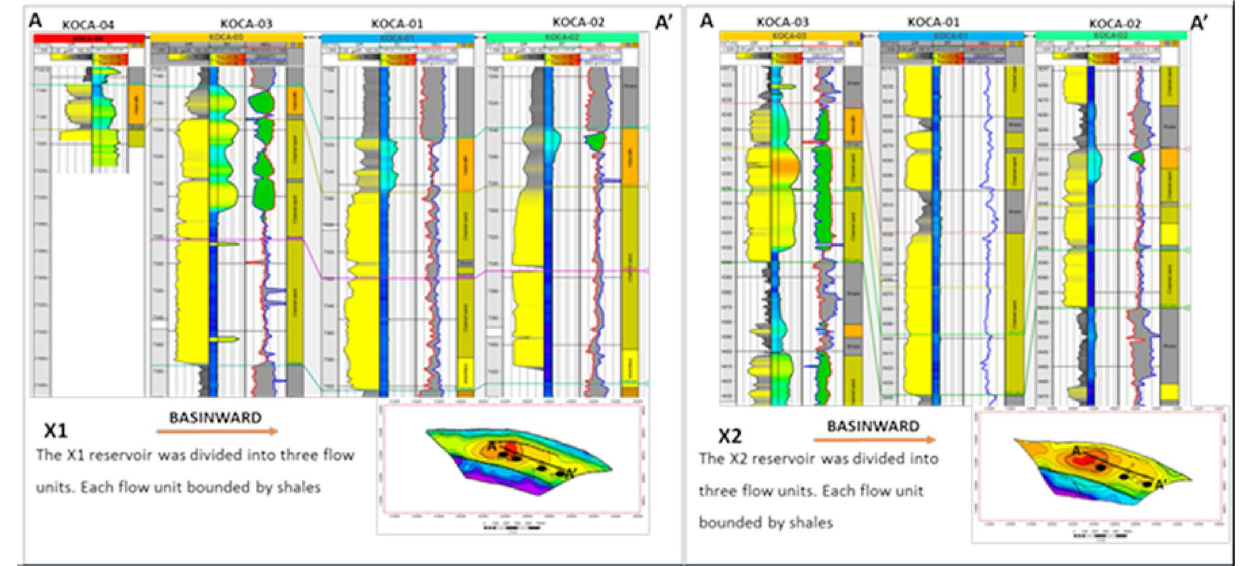
Fig. 11 Reservoir and intra-reservoir correlation